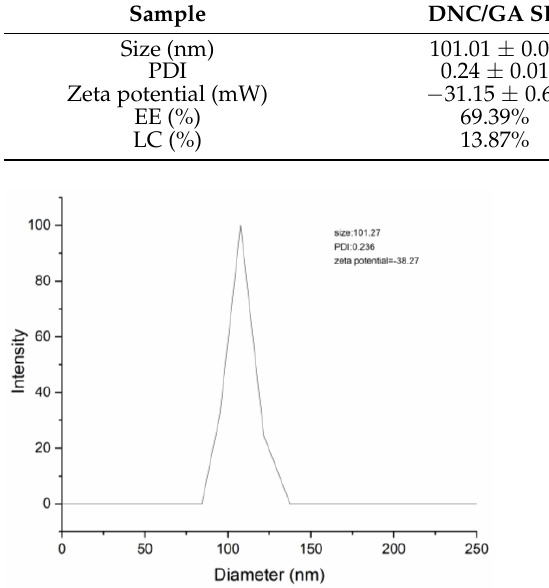
Figure 6. The particle size of DNC/GA/PVP K30 SD. 3.7. TEM